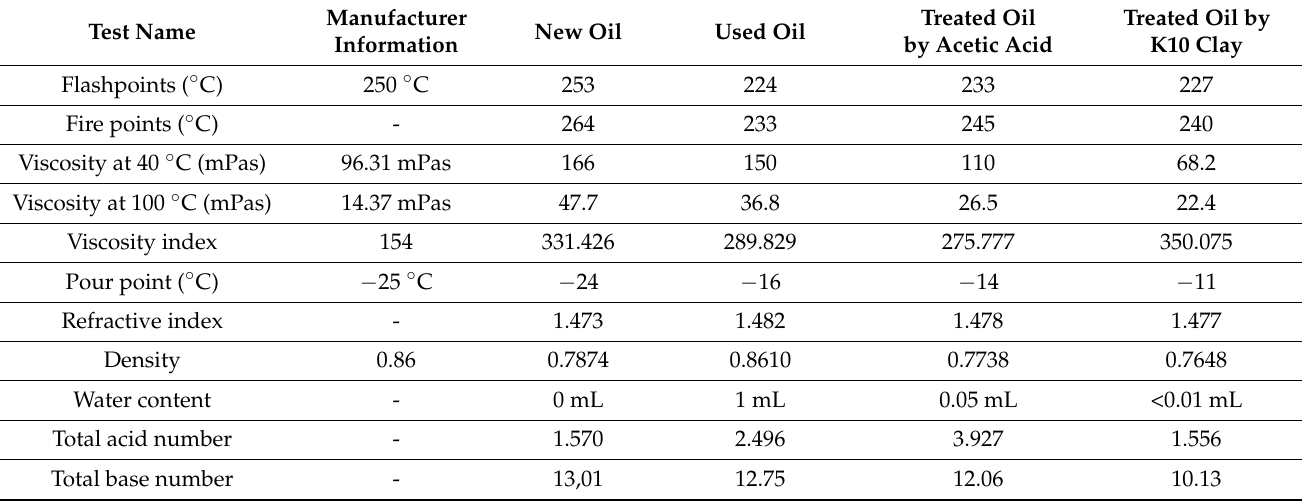
Table 1. Results of the analysis of oil’s physical and chemical properties.